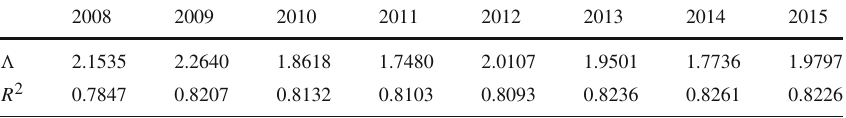
Table 6 Estimates to determine the scenario for Spanish local governments dataset